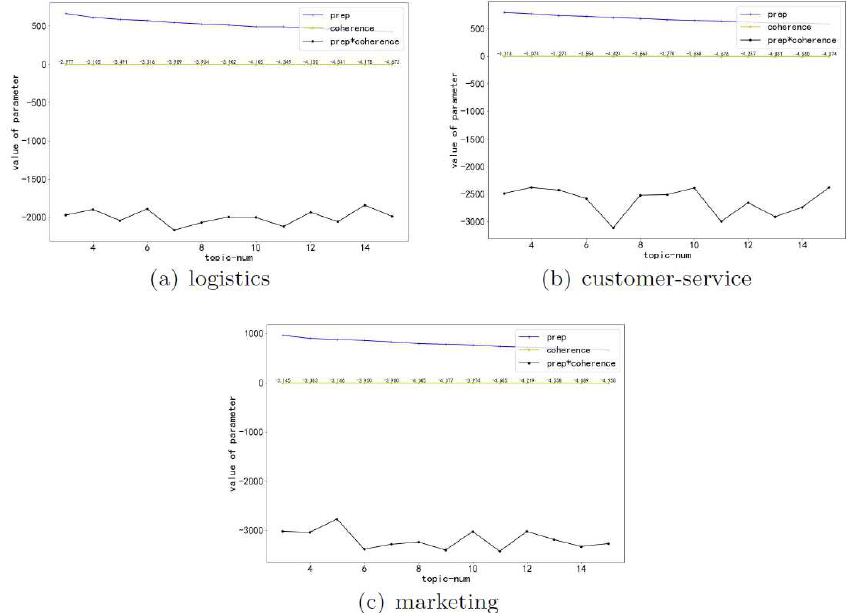
Figure A6. Parameter selection. ( a – c ) are curves for the main reasons of logistics, customer service and marketing, respectively. The x -axis corresponds to the number of topics for model training, and the y -axis represents the value of multipliers. It is worth mentioning that this curve was not the only basis of parameter selection. The topic content and topic number were also considered.